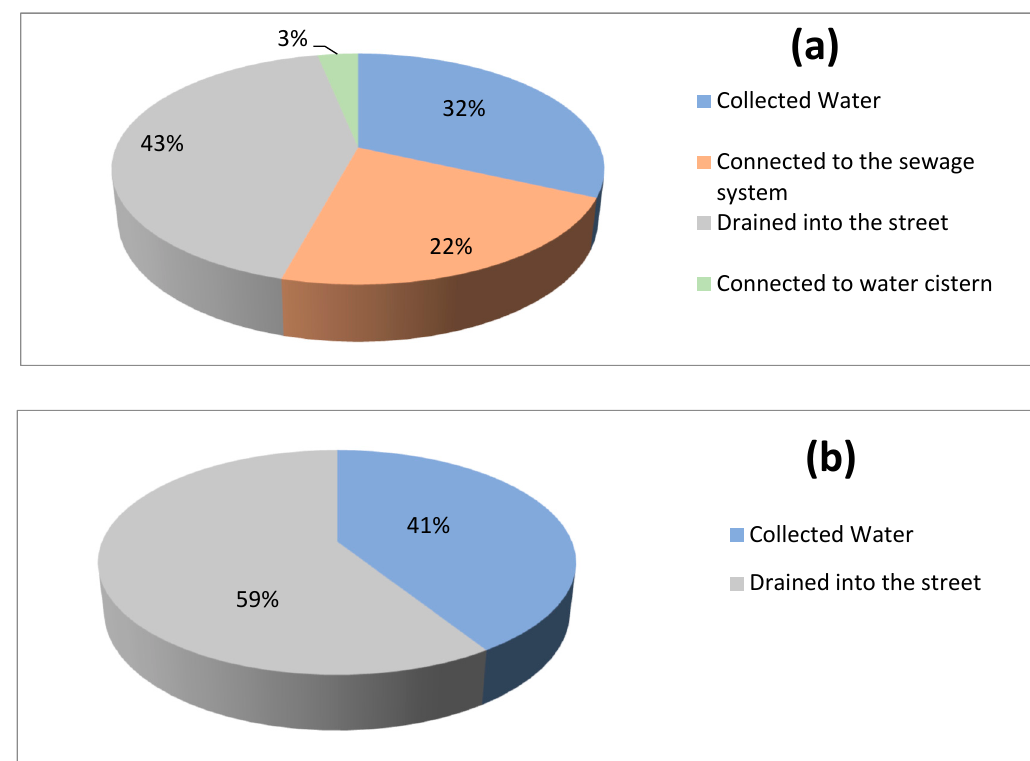
Figure 8. Common methods used to manage the condensate water: ( a ) in Ramallah city and ( b ) in Jericho city.